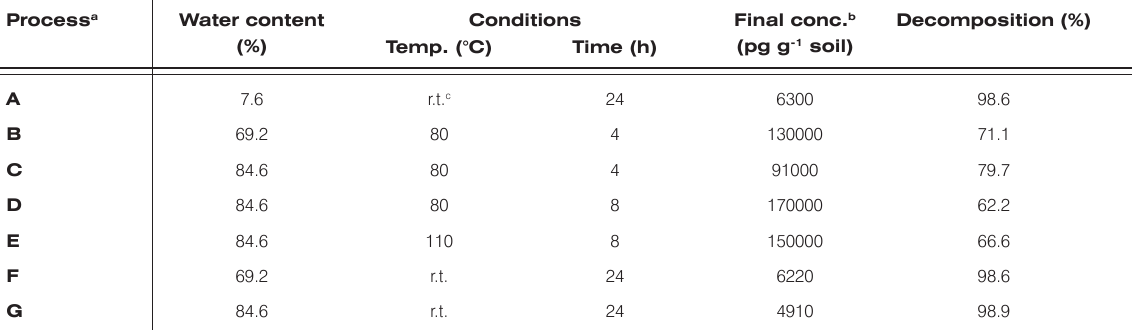
Table 1. Decomposition of PCDDs/PCDFs/co-PCBs in wet soil with a Ca + Rh/C system in a methanol-based solution, contained in a sealed tube. Process